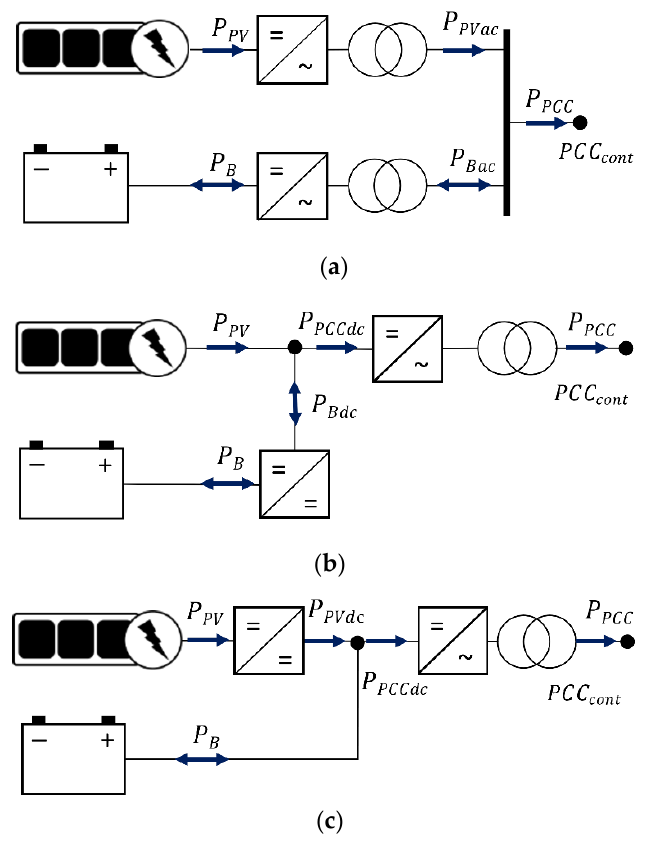
Figure 8. Power flows that involve the three different layouts: ( a ) AC coupling; ( b ) DC-coupling/BESS-side; ( c ) DC-coupling/PV-side.